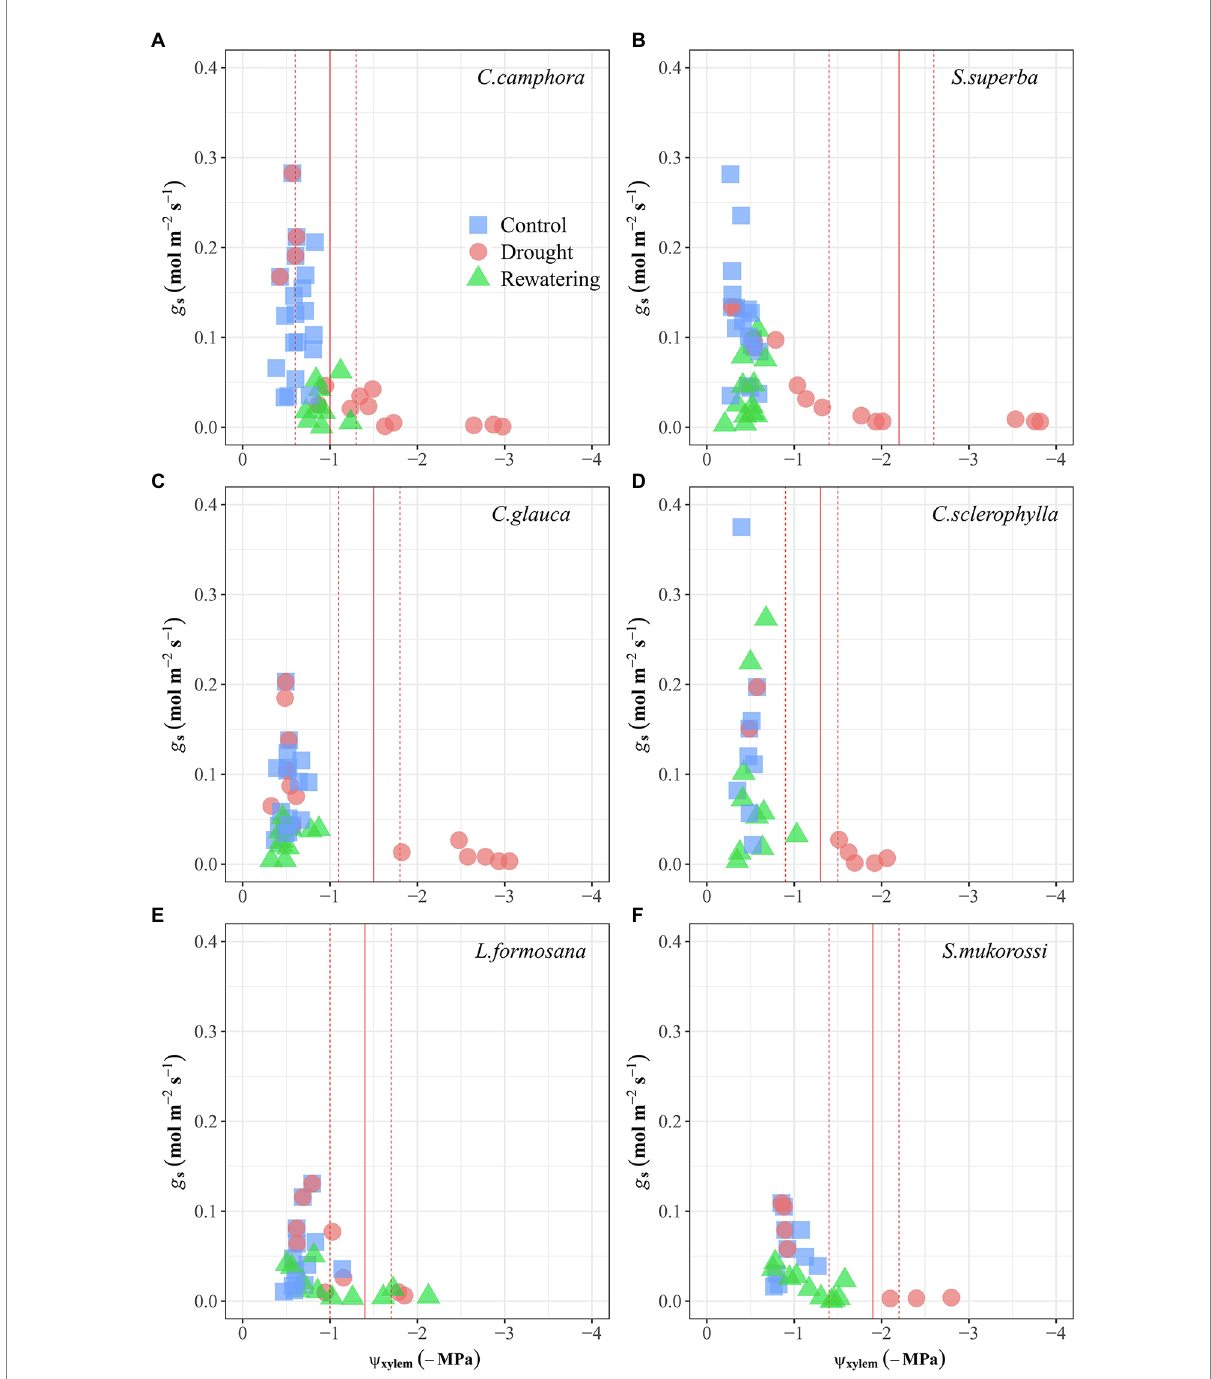
FIGURE 3 Leaf stomatal conductance ( g s ) as function of xylem water potential ( Ψ xylem ) for seedlings of the six tree species during drought and recovery periods. Values are raw points. Solid lines represent the Ψ xylem for 80% loss of g s ( Ψ g s80 ), which were determined by the regressions fitted with a “sigmoidal” model. Dashed lines represent 95% confidence interval (CI). The first four species are evergreen species, while the last two species are deciduous